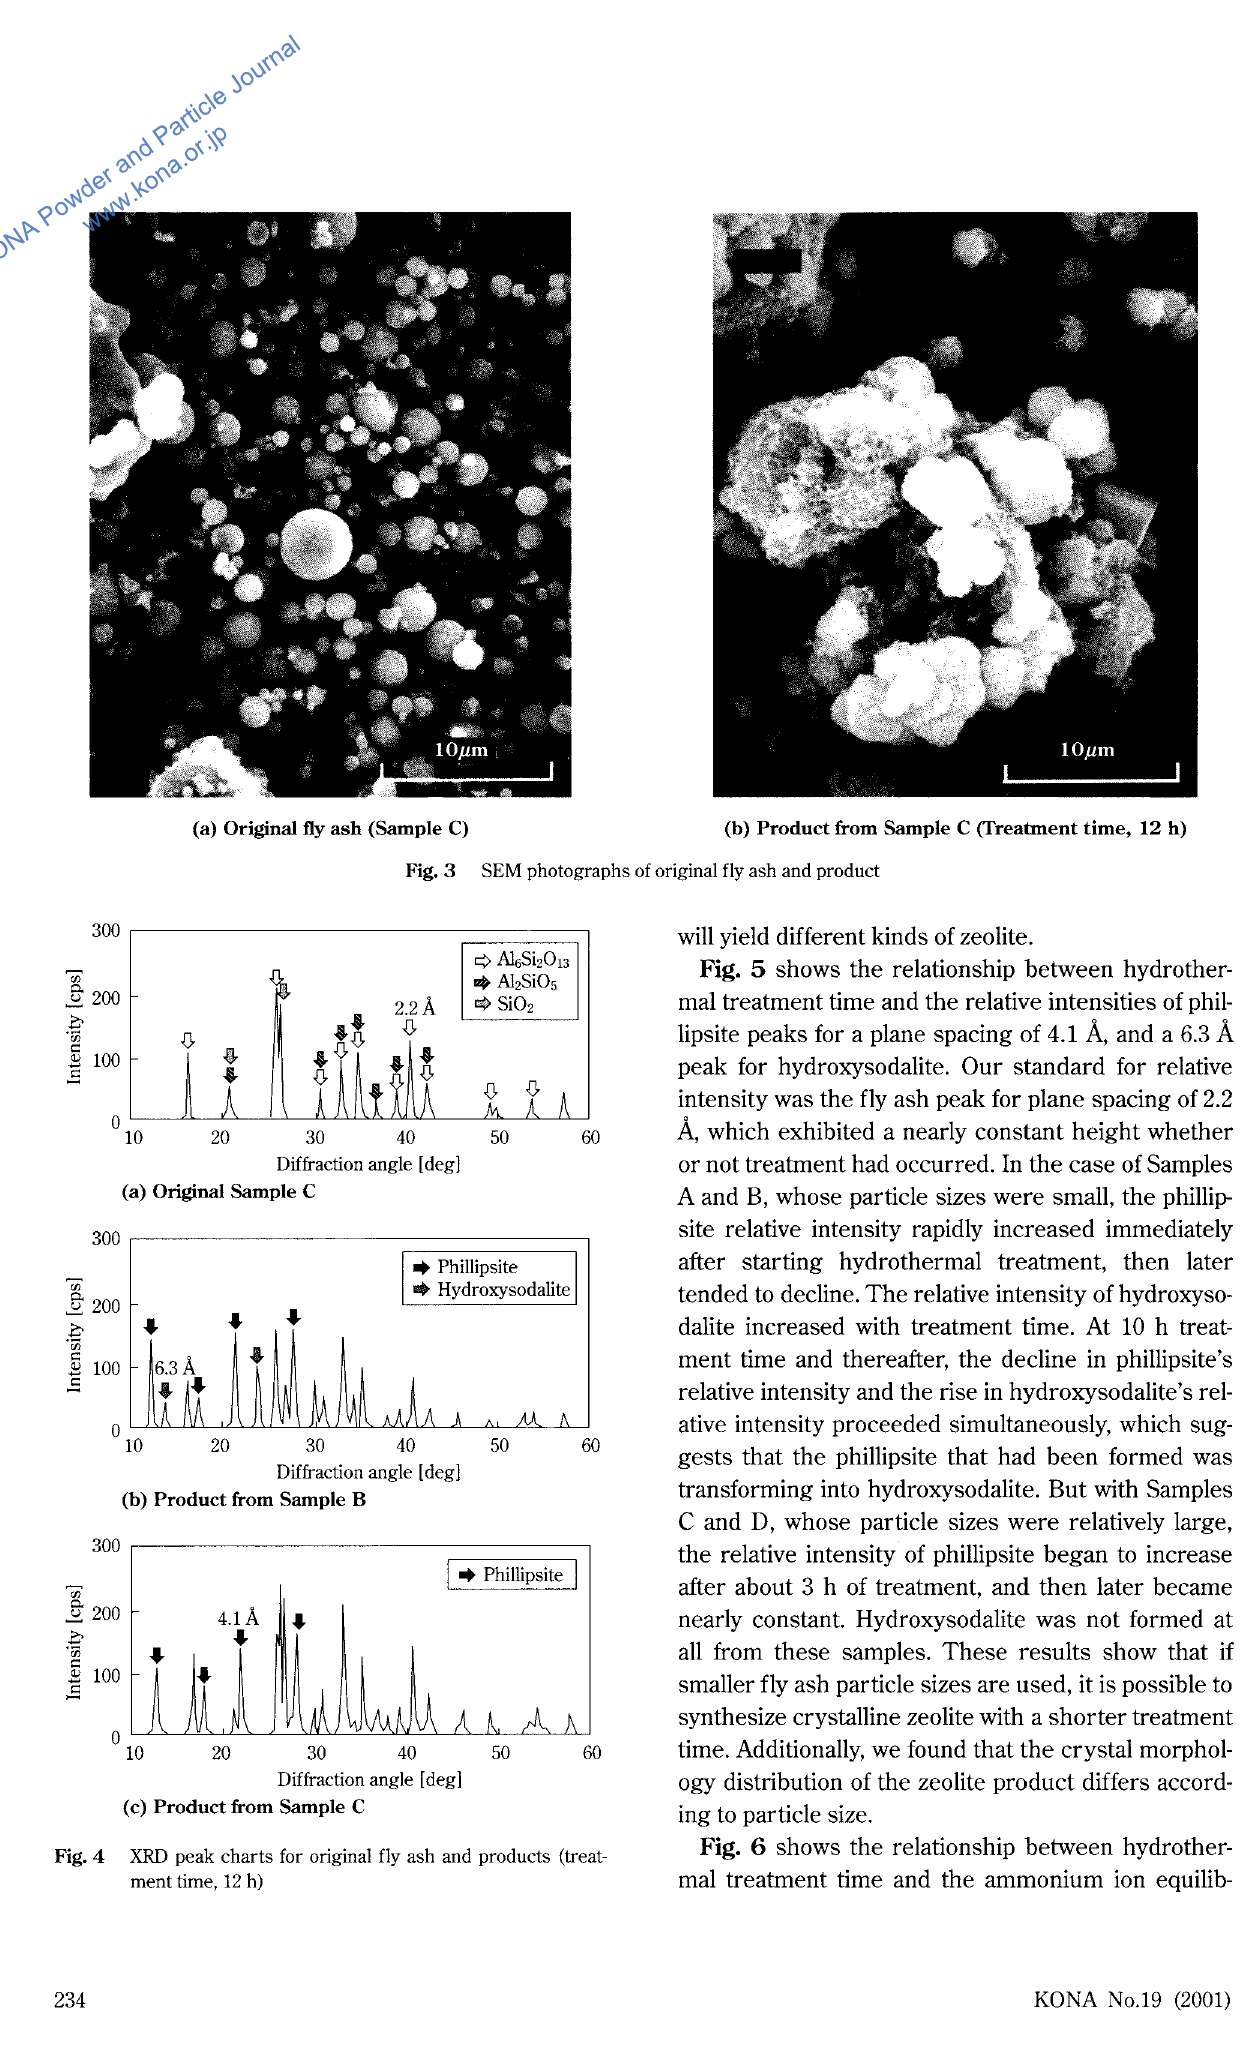
Fig. 3 SEM photographs of original fly ash and product